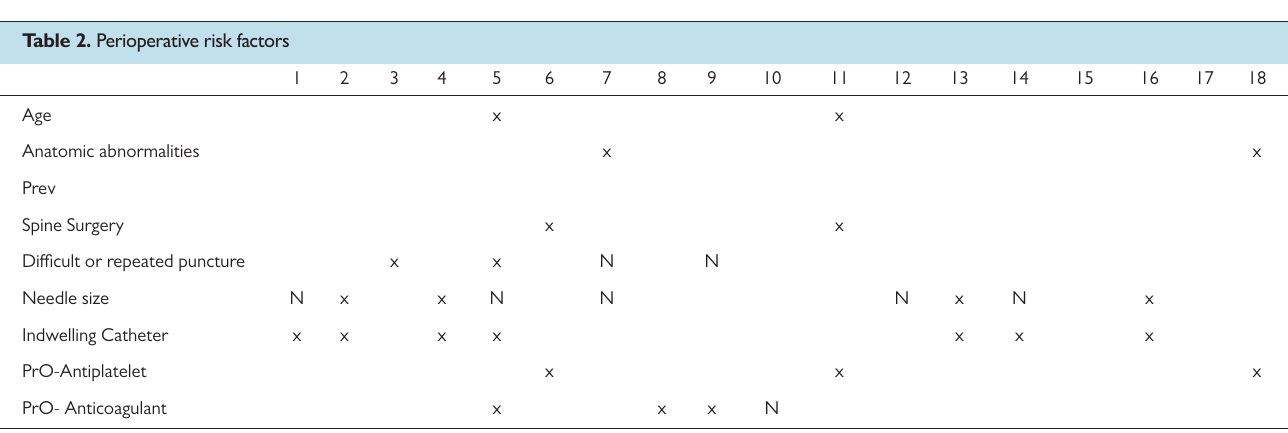
Table 2. Perioperative risk factors